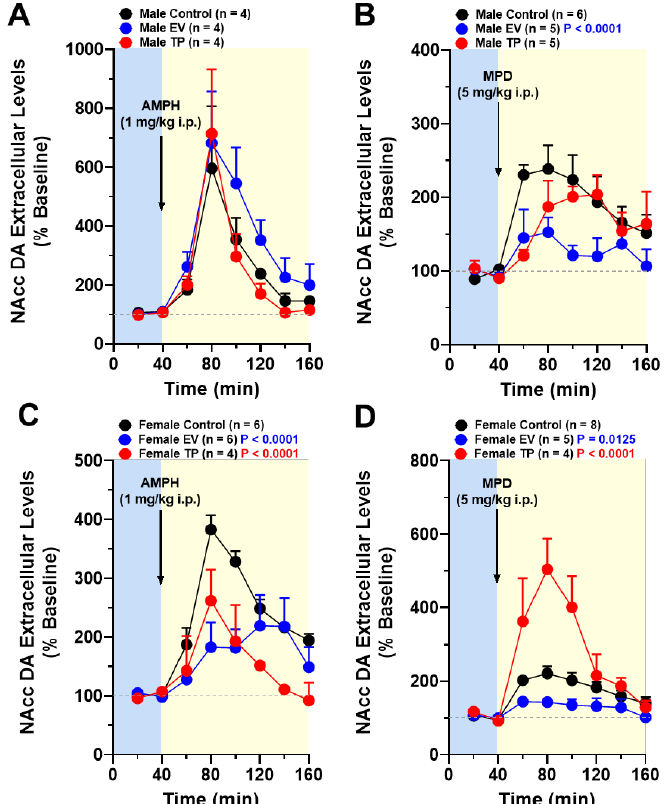
Figure 3. Extracellular levels of dopamine (DA) in nucleus accumbens (NAcc) following systemic administration of AMPH and MPD. Graphs represent the time course of DA release in NAcc expressed as the mean % basal DA release (mean ± SEM) in male ( A , B ) and female ( C , D ) rats neonatally treated with estradiol valerate (EV) or testosterone propionate (TP). Statistical analysis to compare DA release time course curves was performed using a two-way analysis of variance ANOVA.